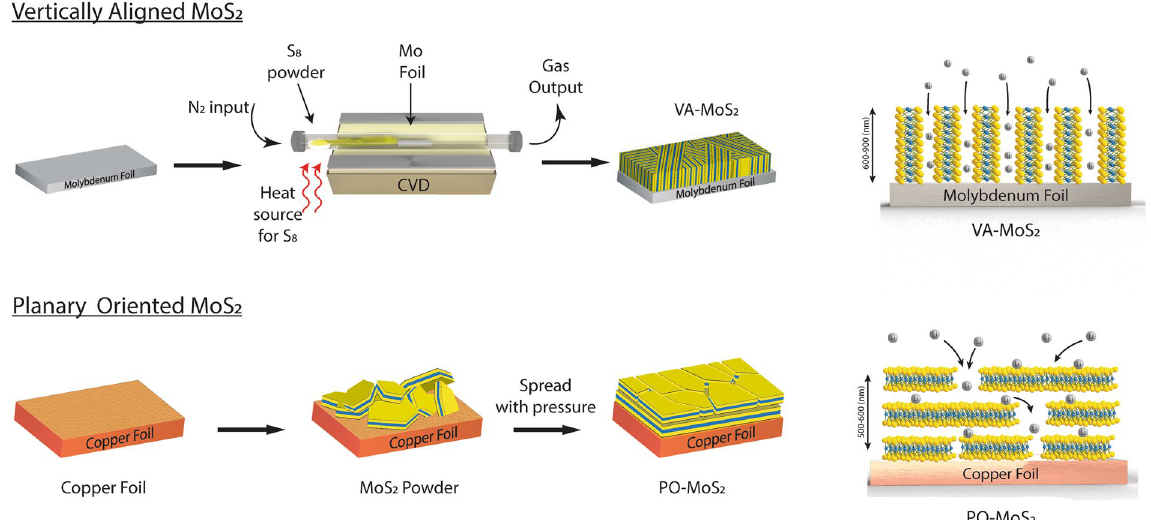
Figure 1. Scheme of the chemical vapor deposition (CVD) experimental set-up and the VA-MoS 2 electrodes, scheme of the preparation of PO-MoS 2 electrodes and expected lithiation